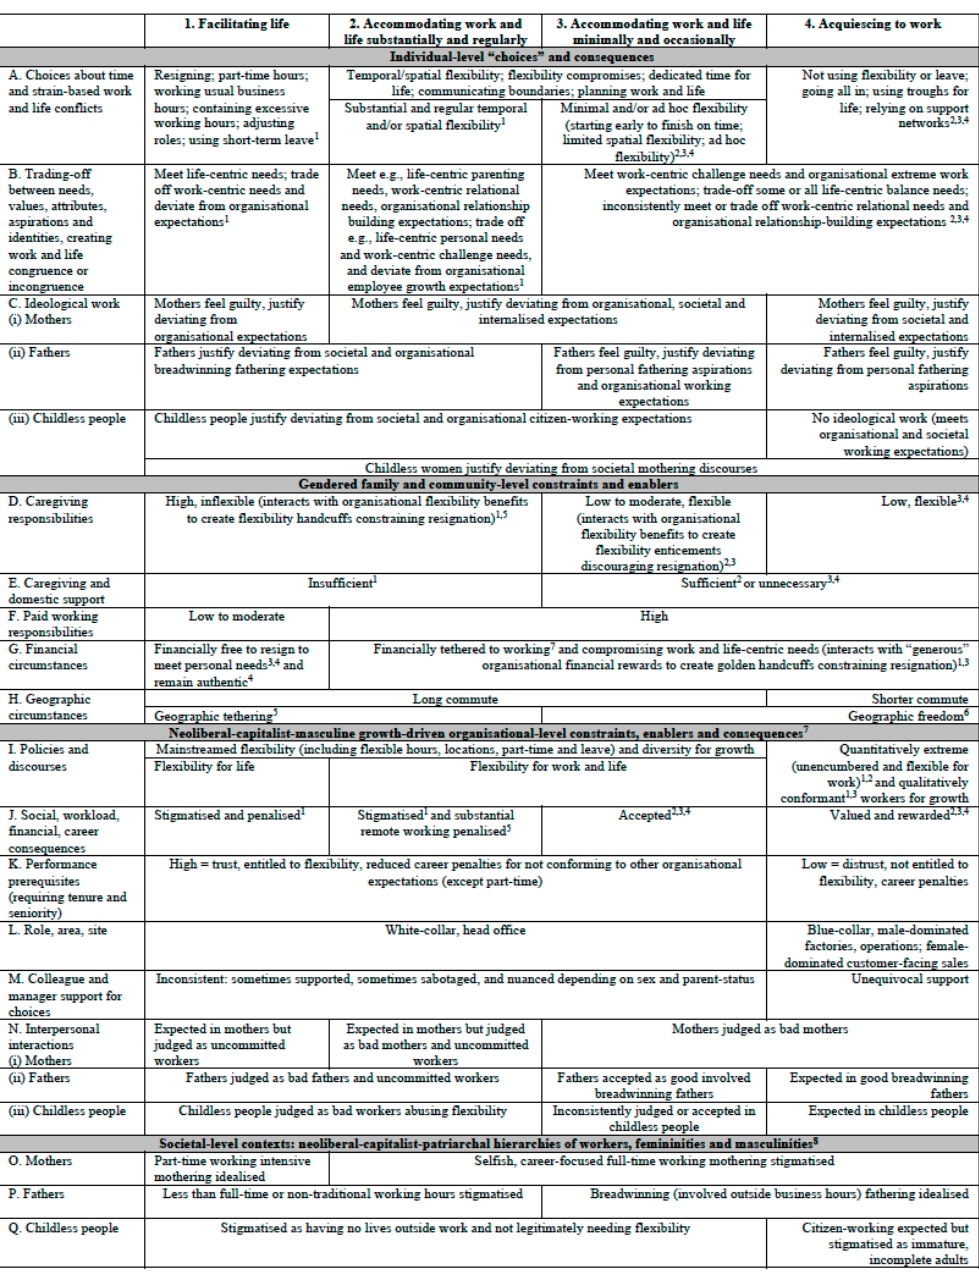
Figure 1. Multilevel continua of work–life “choices” and their constraints, enablers and consequences. Notes: 1 usually mothers with younger children; 2 usually fathers with younger children; 3 usually mothers with older children; 4 usually childless people; 5 usually women and mothers; 6 usually men and fathers; 7 source: Turnbull et al. (2022); 8 source: Turnbull et al. (2020).